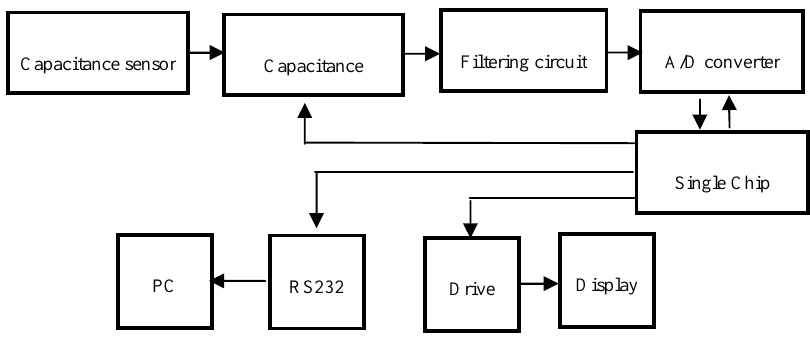
Figure 2. Block diagram of measuring